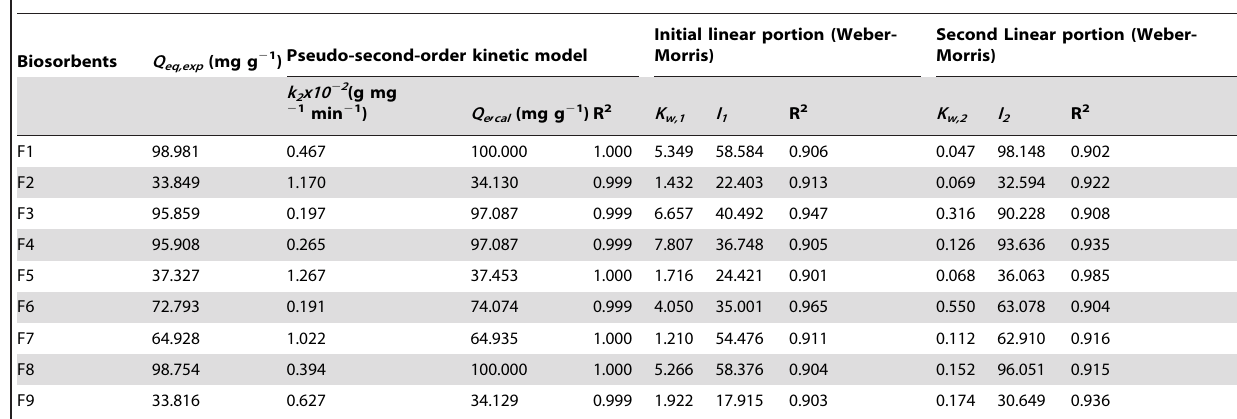
Table 4. Parameters of pseudo-second-order and Weber-Morris model for adsorption of Reactive Black 5 onto biosorbents.